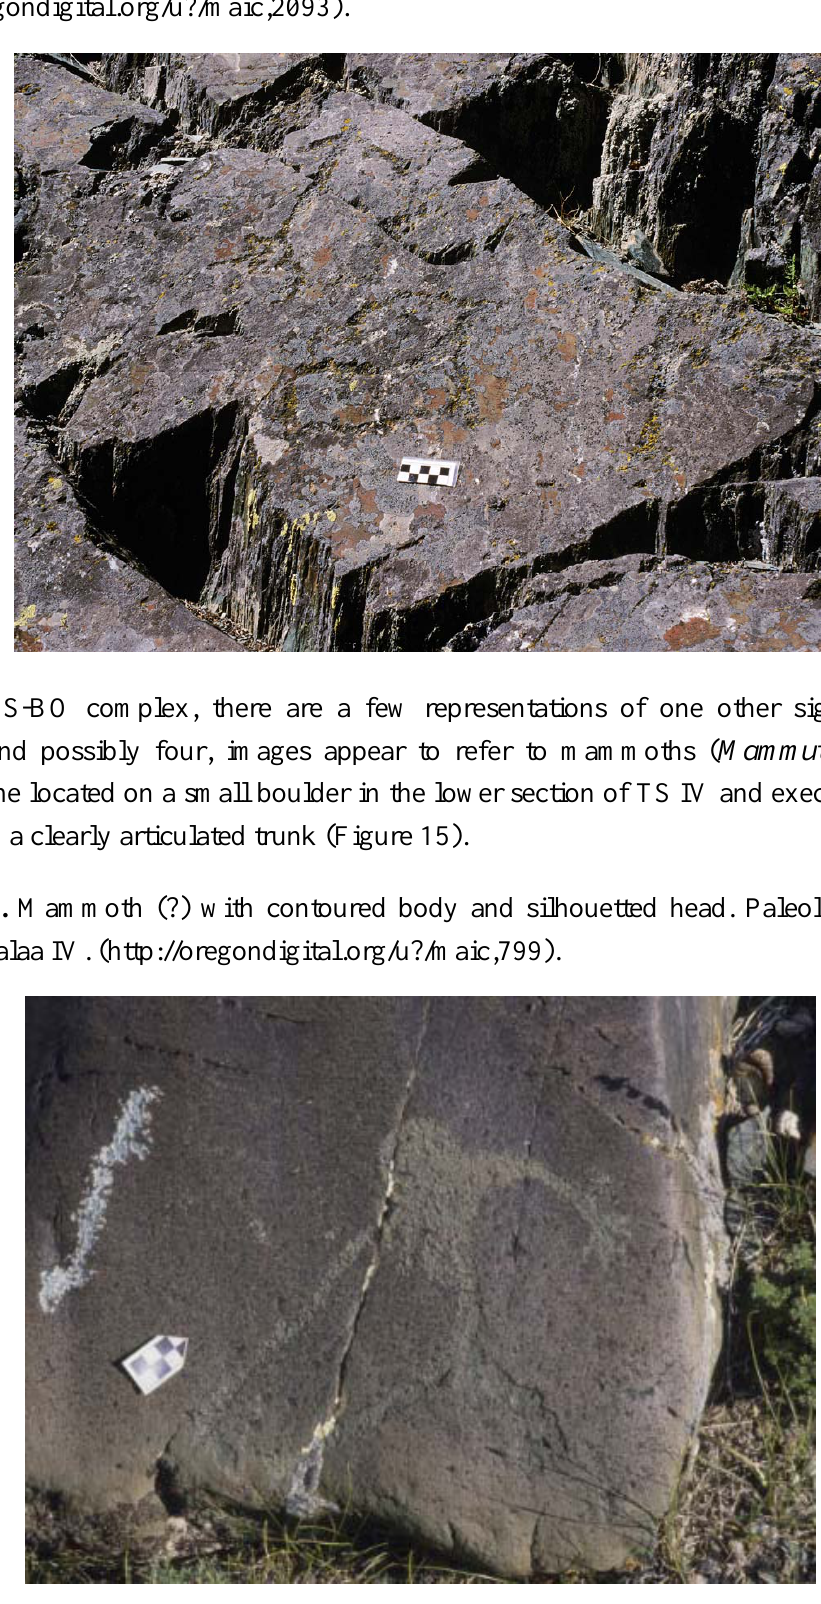
Figure 14. Ibex and frontal stick figures. Pre-Bronze Age. Aral Tolgoi. (http://oregondigital.org/u?/maic,2093).